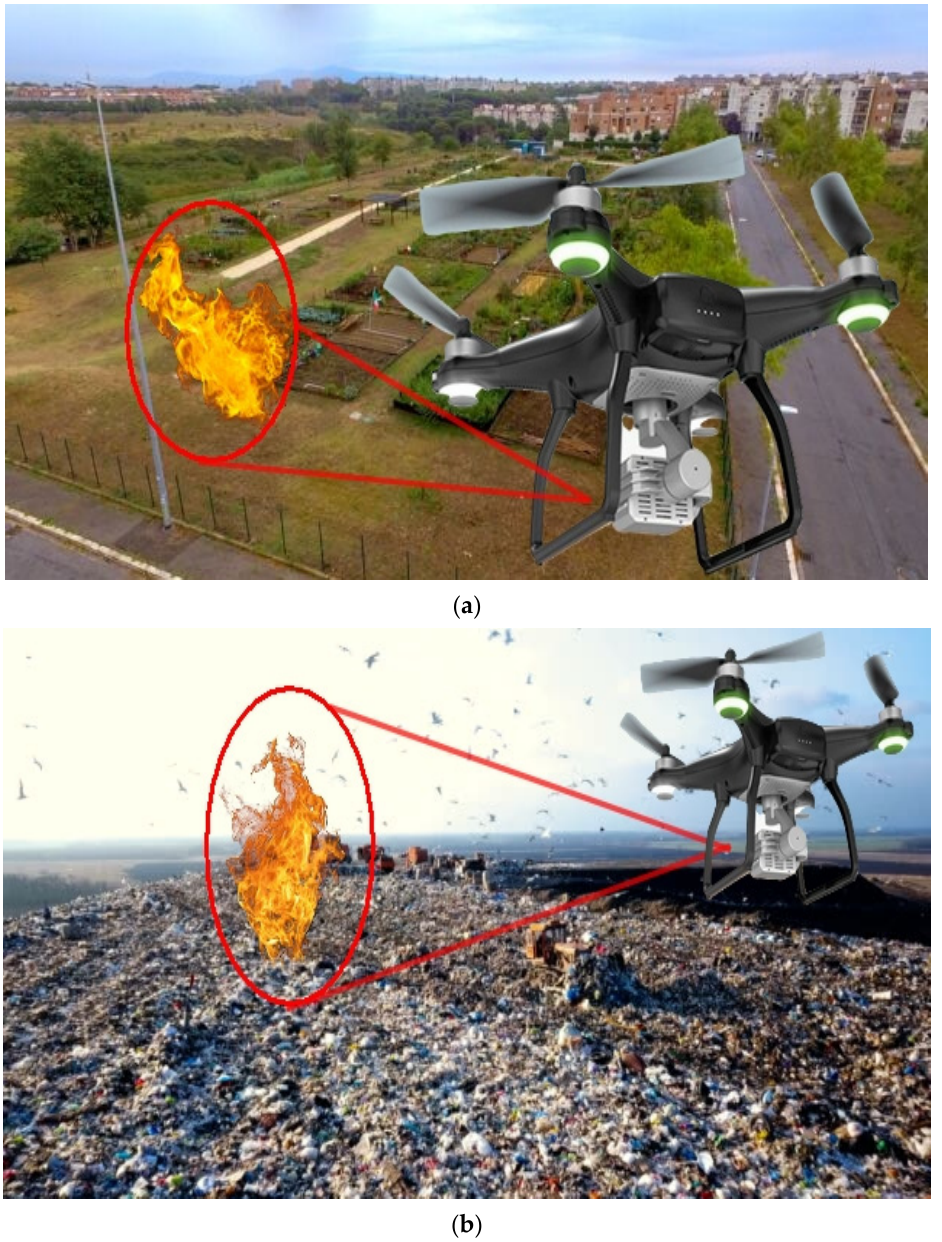
Figure 7. Pictures describing two application scenarios: in a suburban area ( a ); in a landfill ( b ).